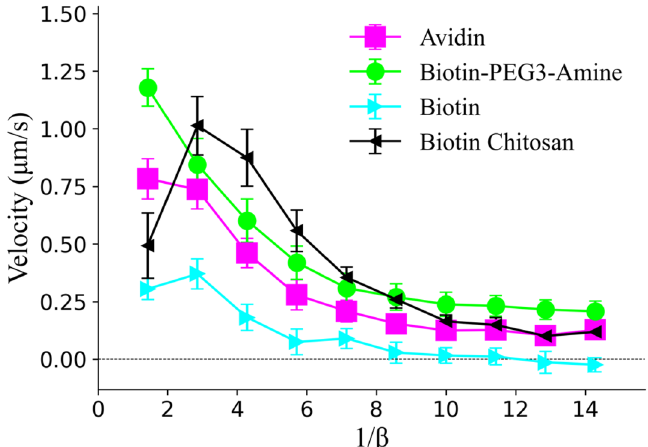
Figure 4. Velocity vs. magnetic field scaling factor for different chemical coatings. Rotation frequency of investigated particles was fixed at 14 Hz. Lines between points were added for visualization purposes and do not represent interpolations. Five avidin, three biotin, four Biotin-PEG3-amine, and four biotin chitosan particles were examined, with each having at least three trials